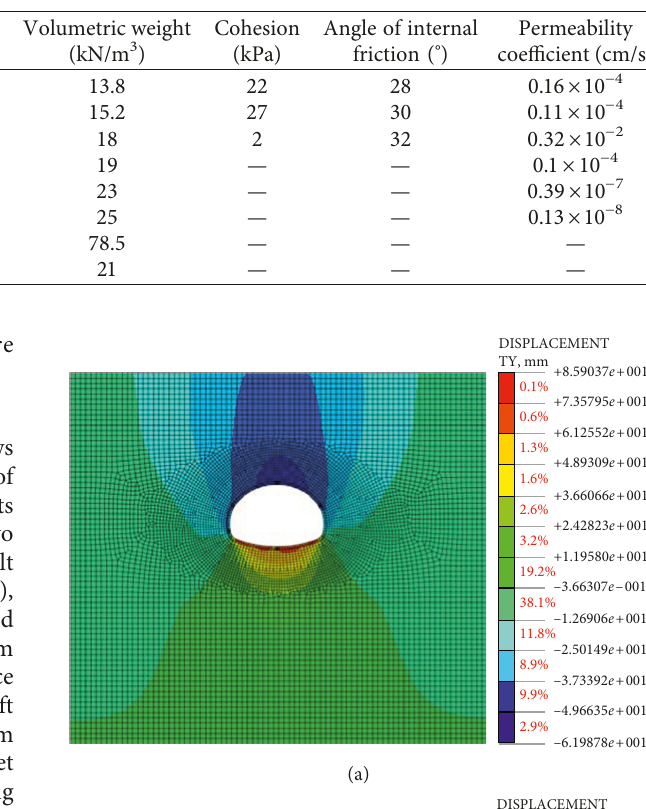
Table 1: Parameters used for numerical simulations [52].